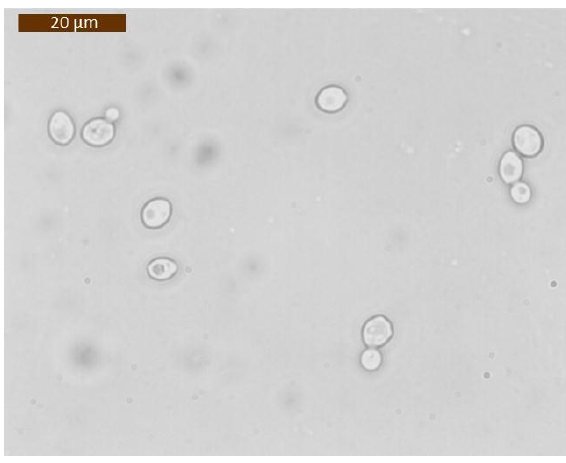
Figure 7. Microscopy image of the Saccharomyces cerevisiae cells used for the experimental testing of the microfluidic devices.